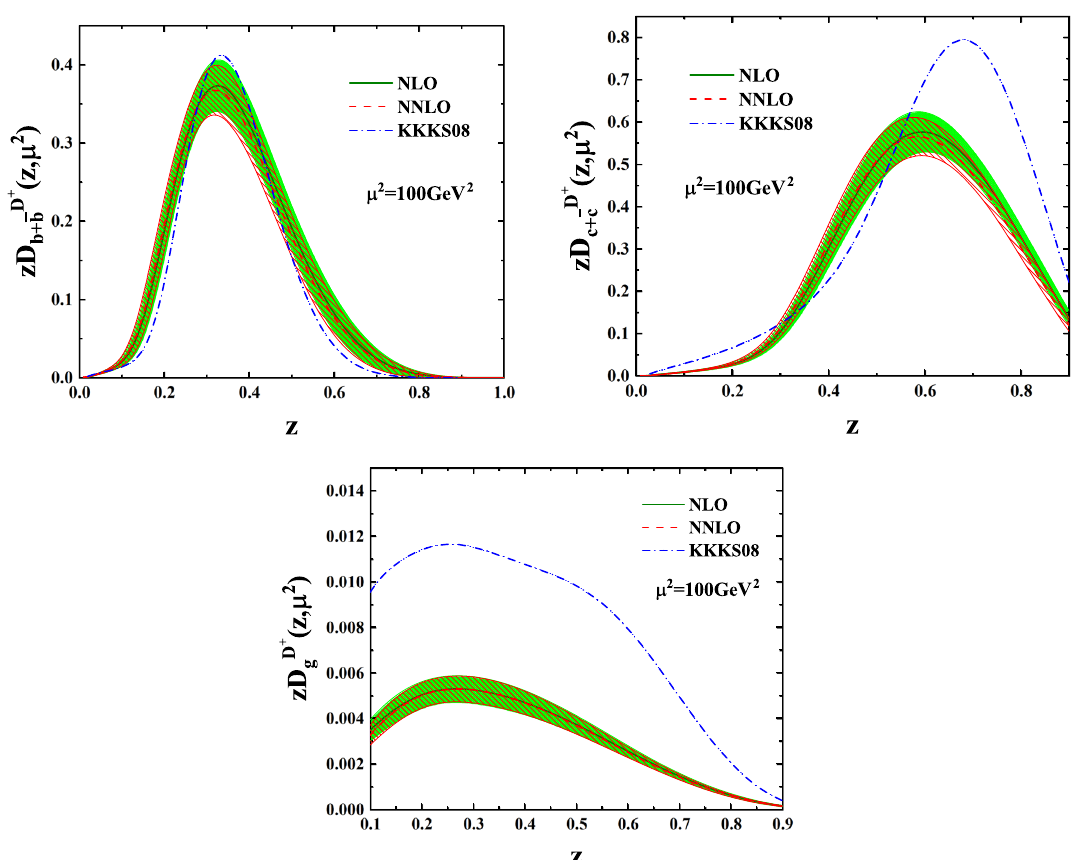
Fig. 2 As in Fig. 1, but for the D + meson